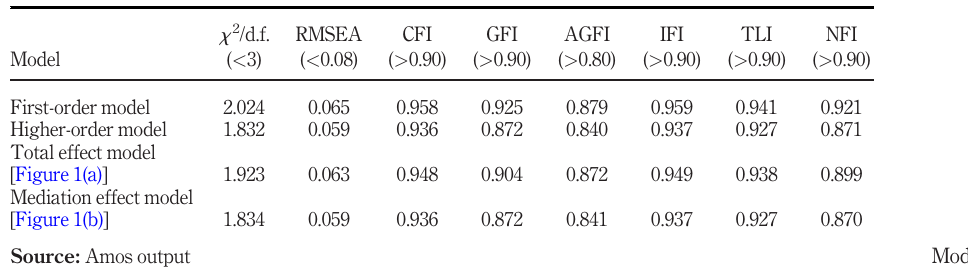
Table V. Model fi t indices